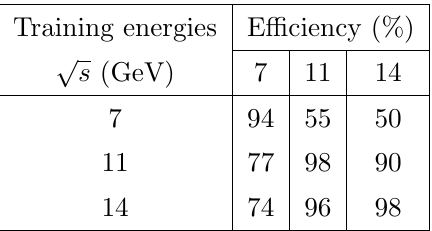
Table 3 . Performance of models trained at di(cid:11)erent